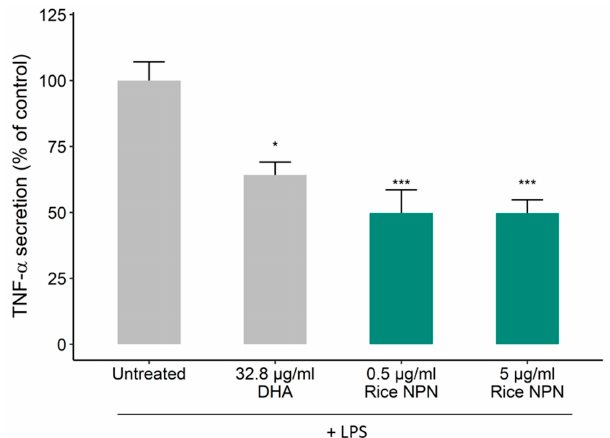
Figure 1. E ff ect of rice natural peptide network (NPN) on lipopolysaccharides (LPS)-induced TNF- α secretion from di ff erentiated THP-1 macrophages. THP-1 macrophages were treated with rice NPN (0.5 and 5 µ g / mL) for 24 h before treating with 100 ng / mL of LPS for 24 h. The secretion of TNF- α was quantified by ELISA. Data presented are the mean ± SEM of at least 3 independent experiments (* p <0.05, *** p < 0.001).